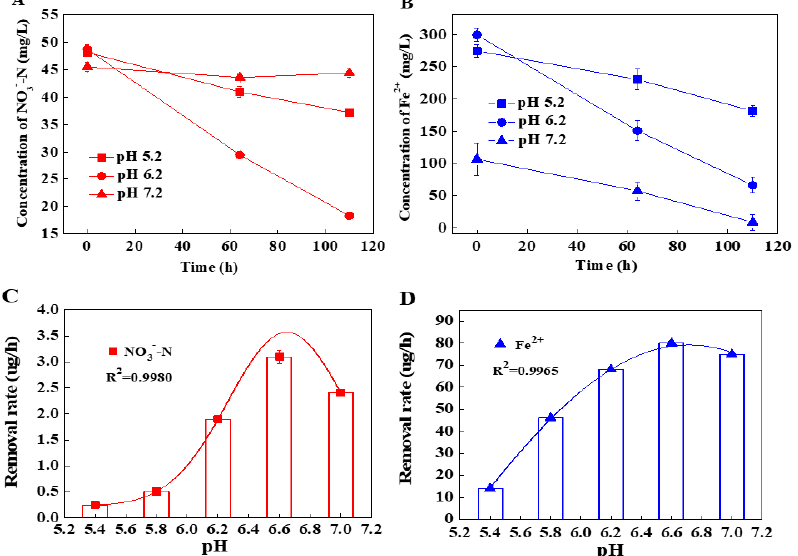
Figure 2. Effects of initial pH on the activity of Shewanella sp. strain F1. ( A ) The nitrate reduction activity along with cultivation time. ( B ) The Fe(II) oxidation activity along with time. ( C ) The removal rate of nitrate − nitrogen under different initial pHs. ( D ) The removal rate of Fe(II) under different initial pHs. The pH affected Shewanella sp. strain F1’s ability to perform Fe − (II)dependent auto- trophic denitrification. A range of pH values was set to determine the optimal pH for strain F1 to reduce nitrate and oxidize Fe(II). The results are shown in Figure 2C,D. In the